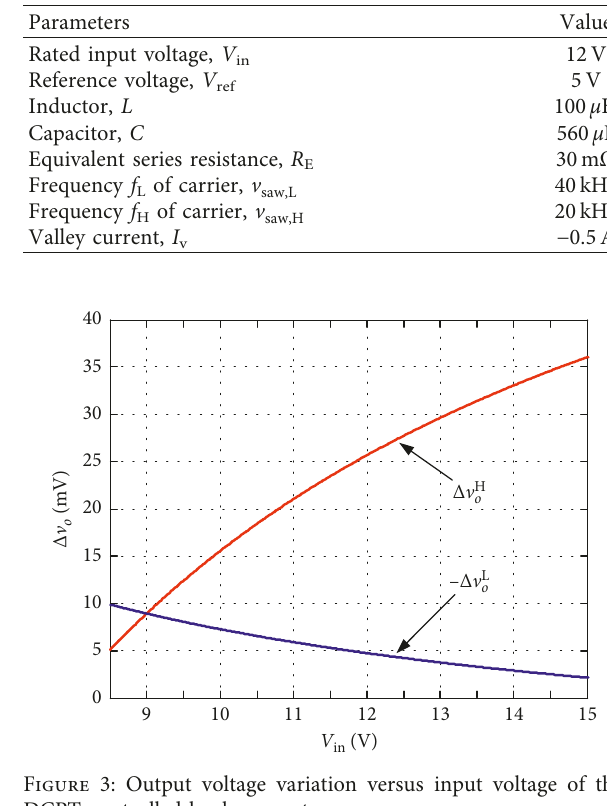
Table 1: Parameters of the DCPT-controlled buck converter.